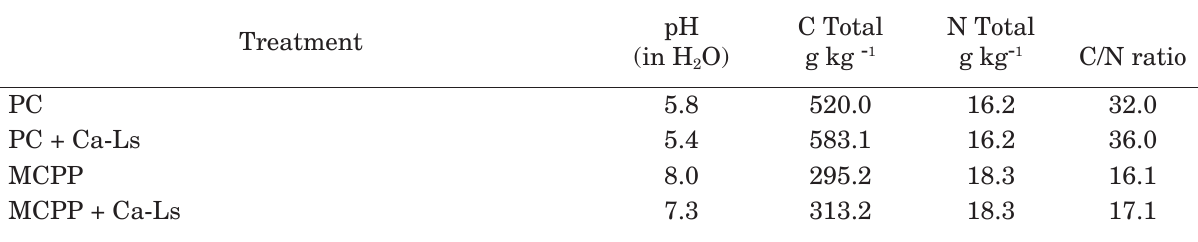
Table 2. Chemical properties of the organic substrates PC (88% peat + 12% coconut fibres) and MCPP (25% municipal compost + 15% peat + 60% pumice) 3 weeks after amendment with 1.5% (v/v) calcium lignosulfonate